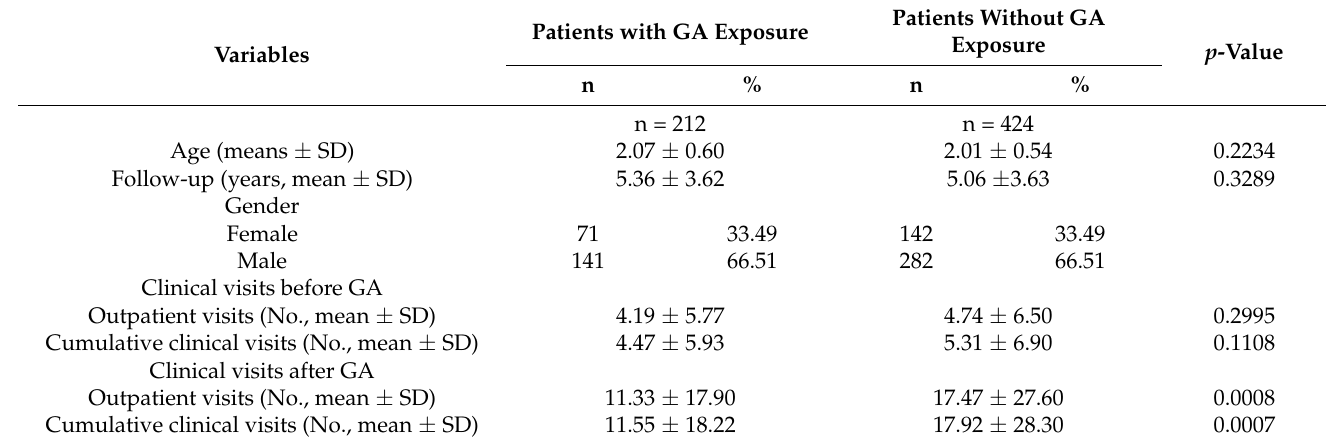
Table 1. Characteristics of the patients with asthma onset before general anesthesia (GA) exposure and unexposed subjects.